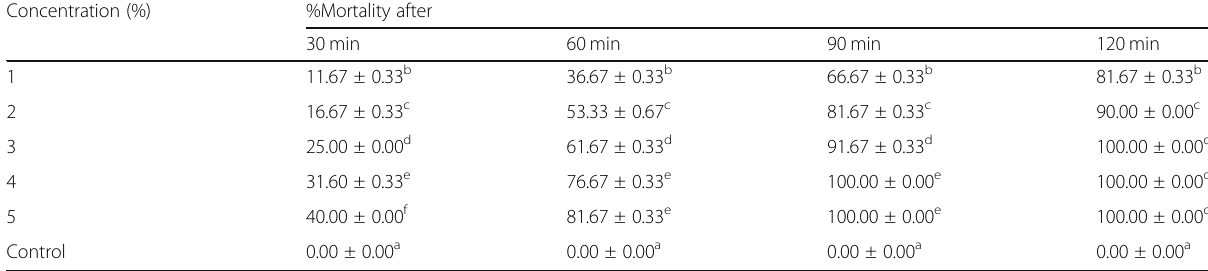
Table 2 Fumigant toxicity of root bark oil extract of P . alliacea on the mortality of adult Culex quinquefasciatus Concentration (%)